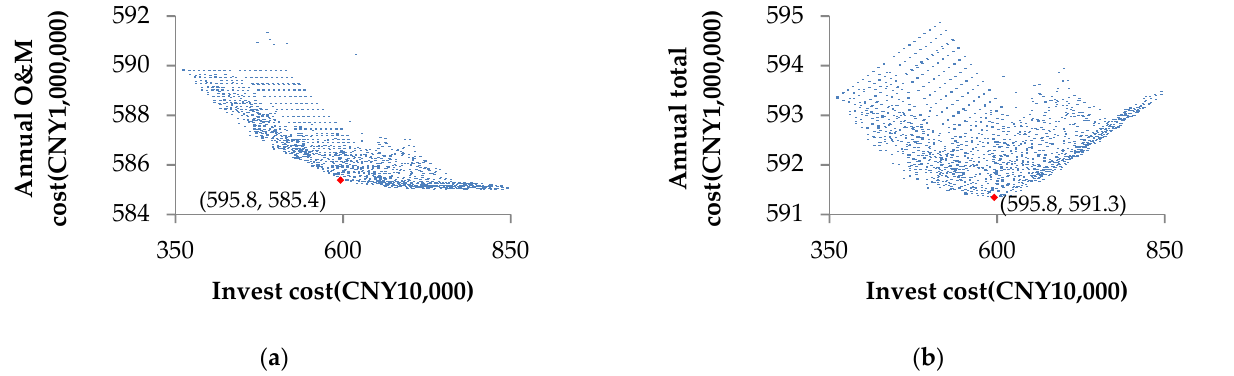
Figure 10. The relationship between cost and investment: ( a ) annual operation and maintenance cost and annual investment cost of DTES; ( b ) comprehensive annual total cost and annual investment cost of DTES.